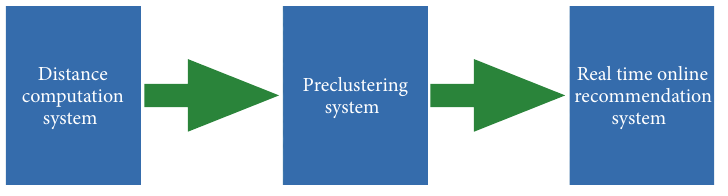
Figure 1: System